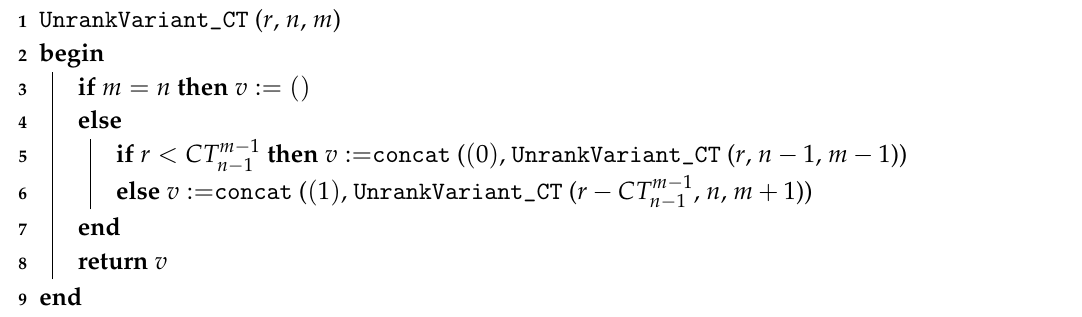
Algorithm 4: An algorithm for unranking the variants of the AND/OR tree for CT m